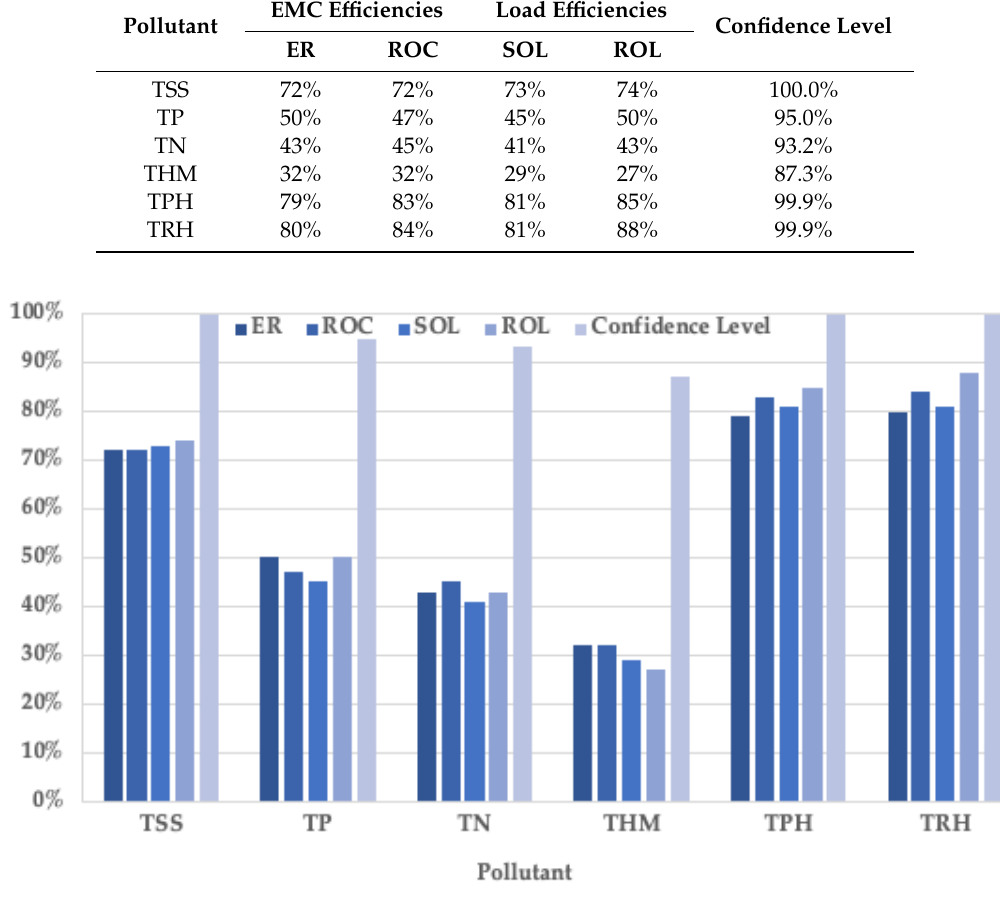
Figure 12. E ffi ciency Results for Ecosol Storm Pit (Class